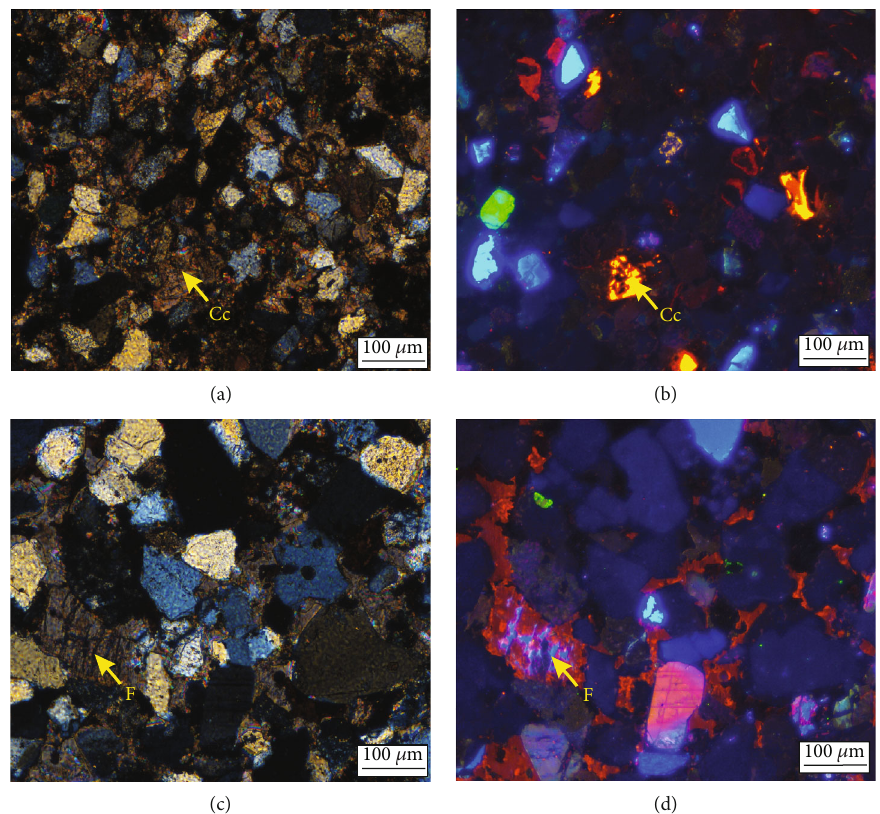
Figure 6: Cathodoluminescence (CL) observation of carbonate cements. (a, b) F1, 3319.1m: calcite (Cc) and ankerite show the yellow and dark luminescence, respectively; (c, d) F104, 3059.4m: the dissolution of feldspar (F) and Fe-calcite show the dark red luminescence.